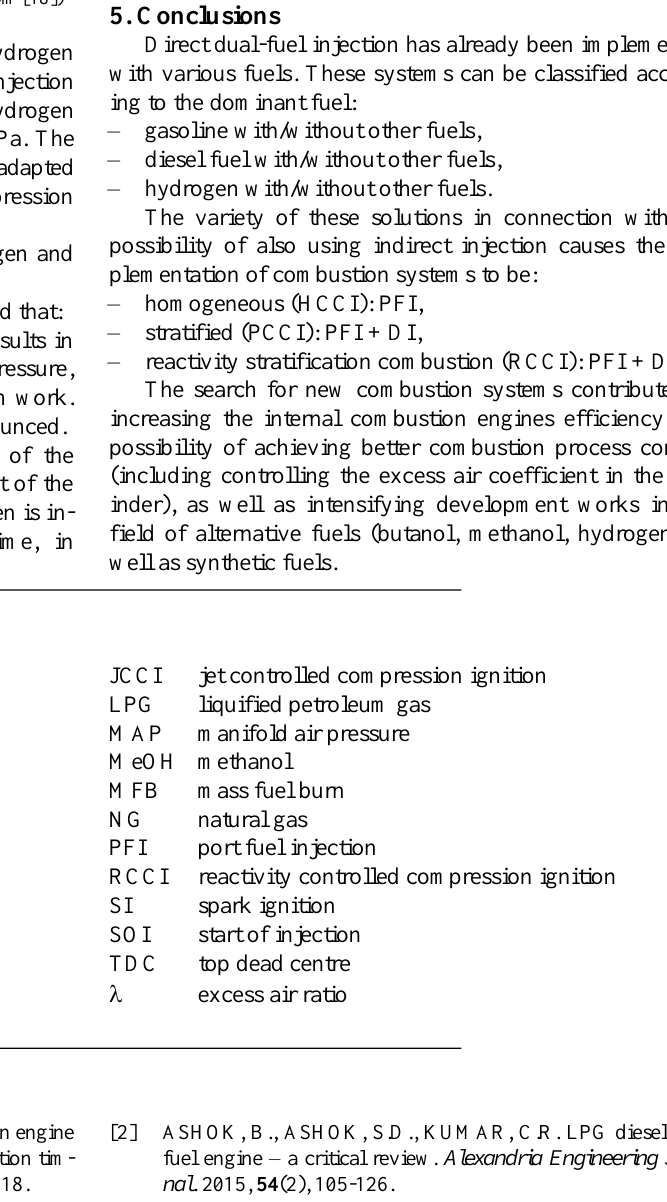
Fig. 18. Effect of hydrogen injection timing on in-cylinder pressure and apparent heat release rate (aHRR) at selected hydrogen energy fractions of 20% (left) and 50% (right) (reproduced from